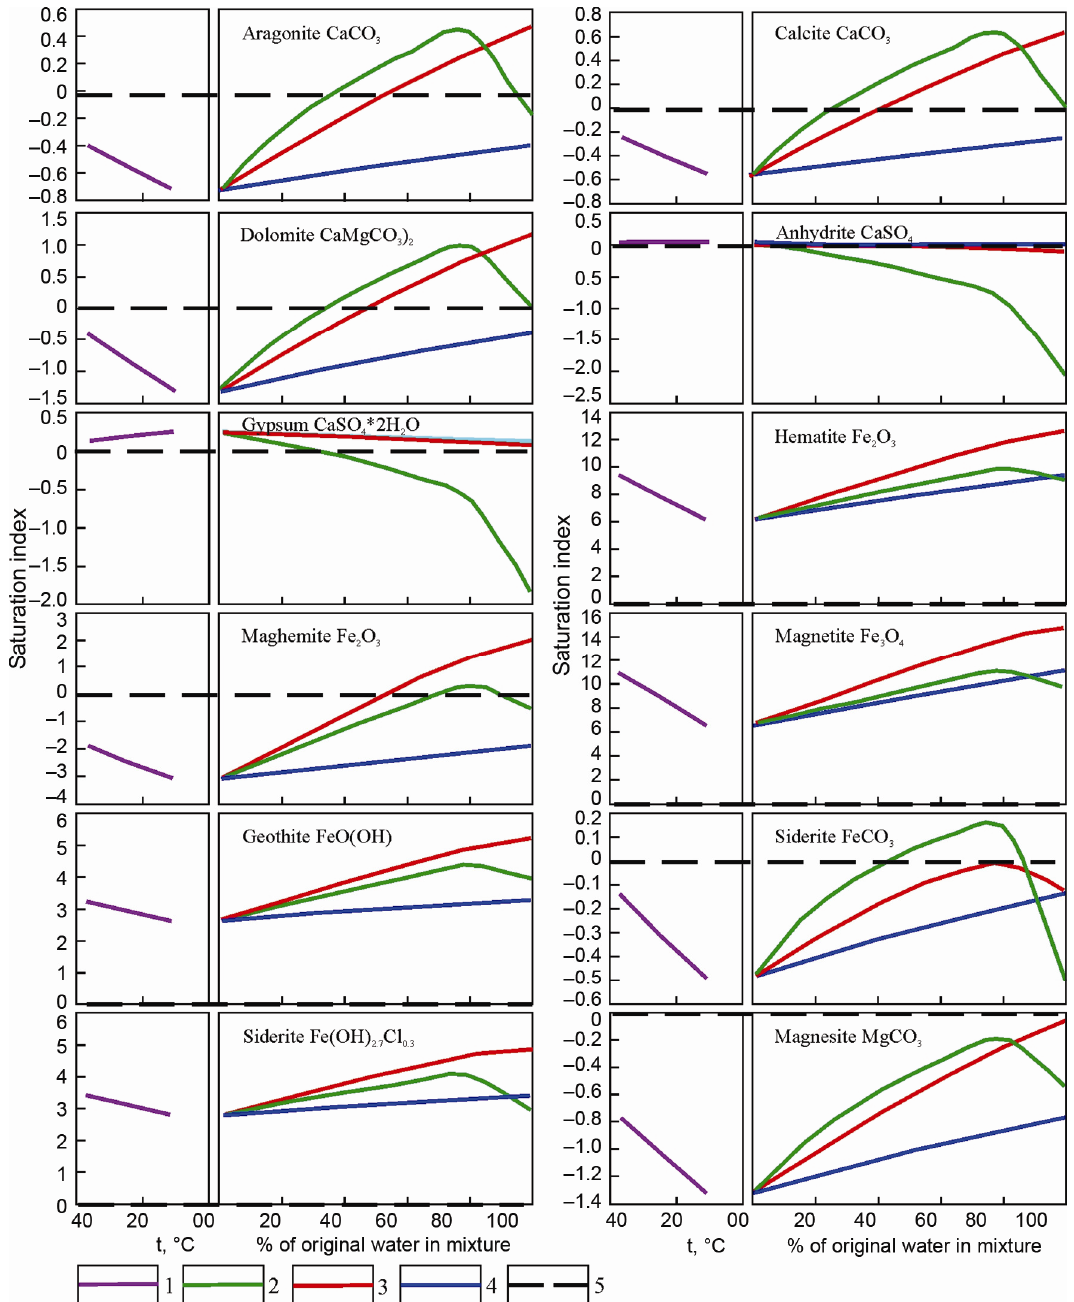
Fig. 11. Predicted saturation of groundwater with minerals: 1 – in the water of Viešvilė aquifer at temperature fall from 37.5 to 11°C; 2–4 – in the Upper Permian–Žagarė, Šventoji–Upninkai and Viešvilė aquifers (respec- tively) after injection of cold (11 ° C) spent geothermal